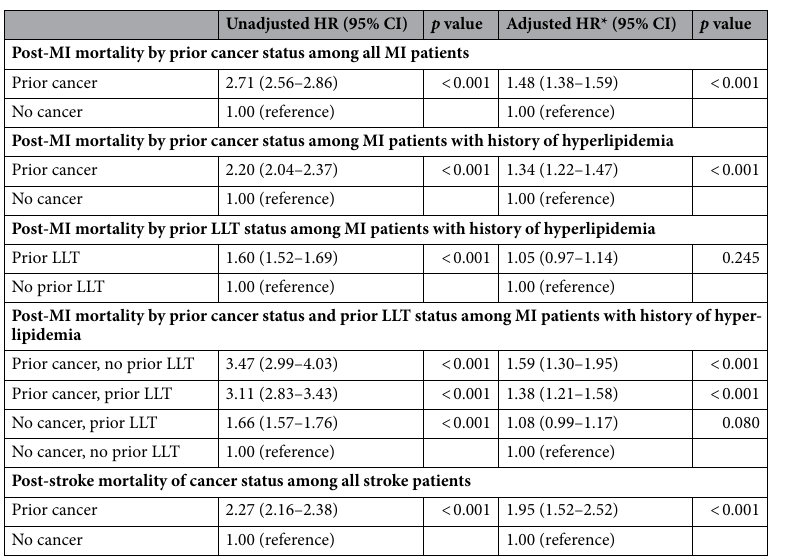
Table 4. Hazard ratio of all-cause mortality in myocardial infarction and stroke patients. CI confidence interval, HR hazard ratio, LLT lipid lowering therapy, MI myocardial infarction. *For MI: Adjusted for age at MI, sex, body mass index, smoking, prior treatment for hypertension, prior treatment for diabetes mellitus, LDL-C, left ventricular ejection fraction, ST-segment elevation MI, cardiac arrest, heart failure, and revascularisation. *For stroke: Adjusted for age at stroke, sex, smoking, history of hypertension, history of diabetes mellitus, history of hyperlipidaemia, history of transient ischaemic attack or stroke, history of ischaemic heart disease, history or newly diagnosed atrial fibrillation or flutter, LDL-C, and baseline National Institutes of Health Stroke Scale